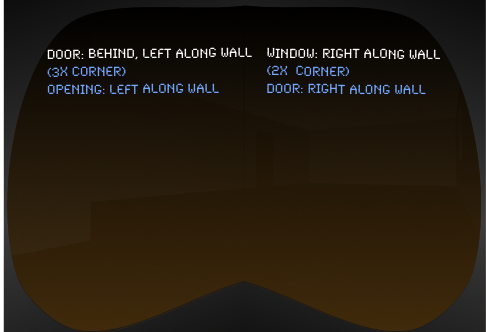
Figure 10: Firefighter perspective in burning building with smoke-filled interiors; the specialised route graph is required for navigation